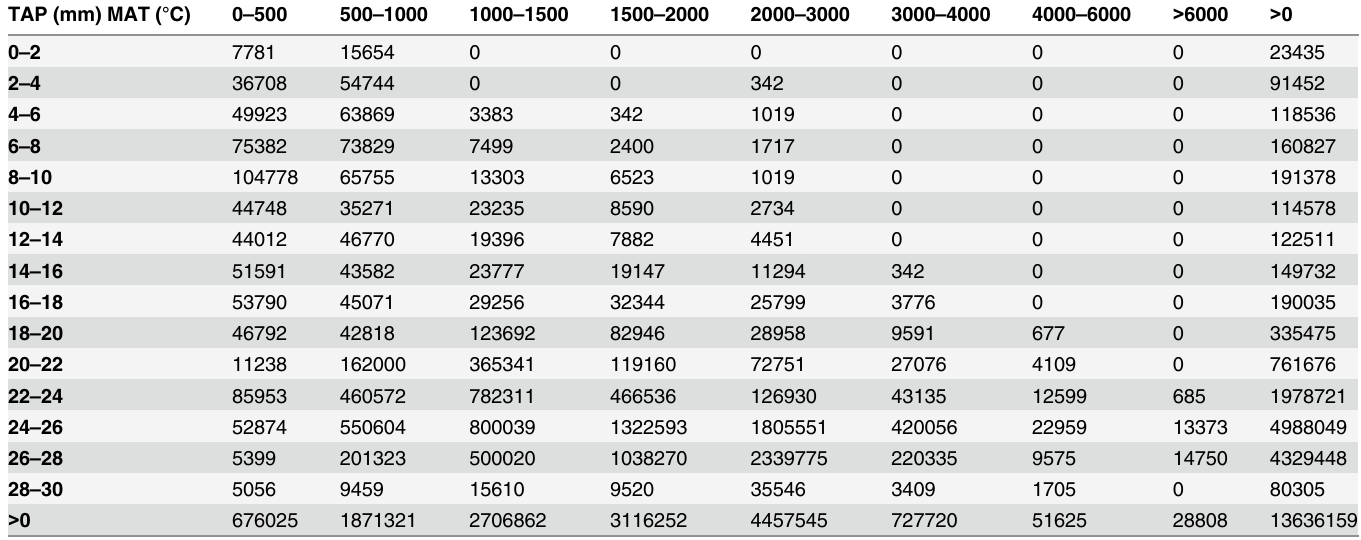
Table 3. The extent of land area (km2) under different climatic conditions as defined by current Total Annual Precipitation (TAP) and Mean Annual Temperature (MAT). TAP (mm) MAT